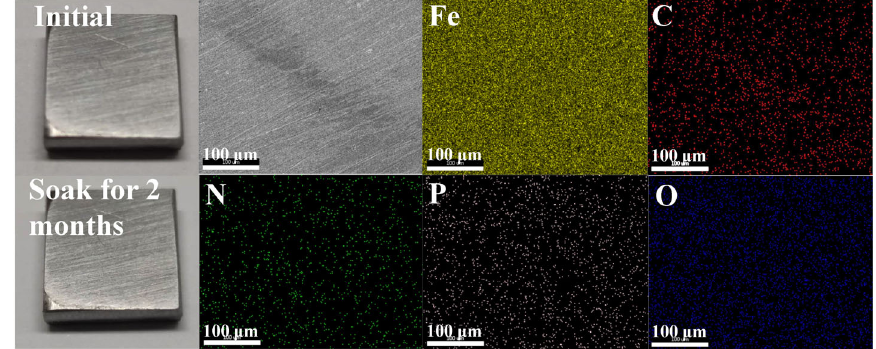
Fig. 11 Optical photos before and after the corrosion test and EDS analysis of the iron surface after two months of